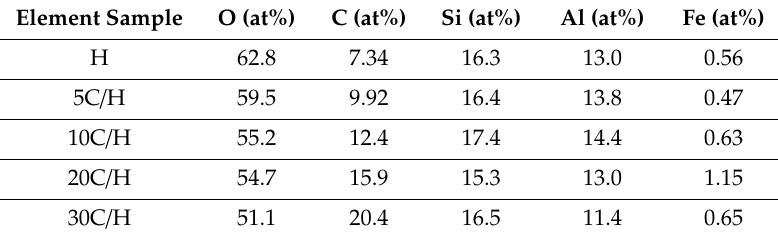
Table 1. Atomic concentration (at%) of elements in the halloysite mineral for the H sample and the halloysite-carbon nanocomposites (5 C / H, 10 C / H, 20 C / H, and 30 C / H) determined using the XPS